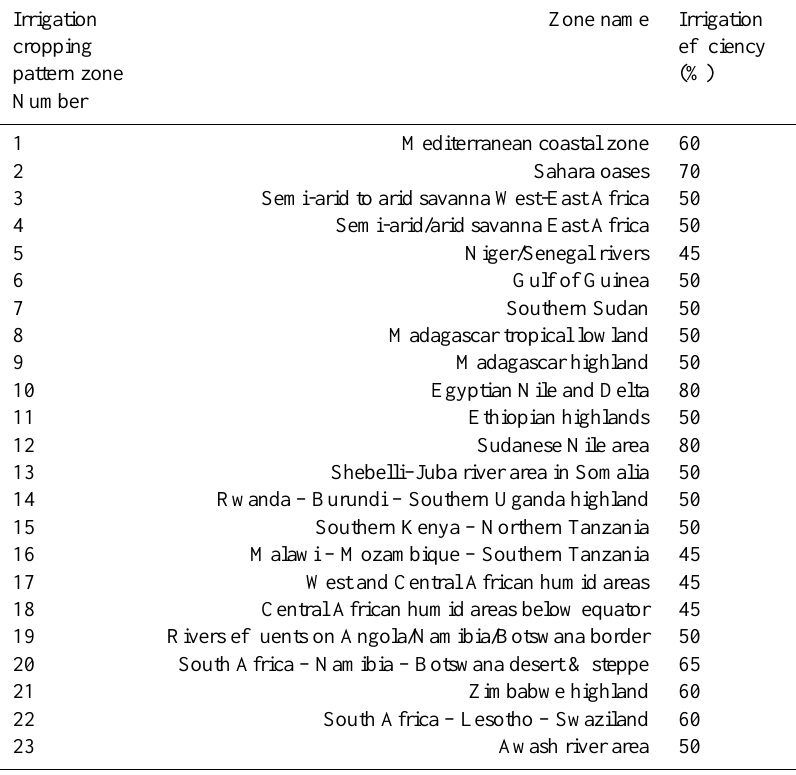
Table 2. Irrigation efficiency dependent on irrigation cropping pattern zone (FAO, 1997).